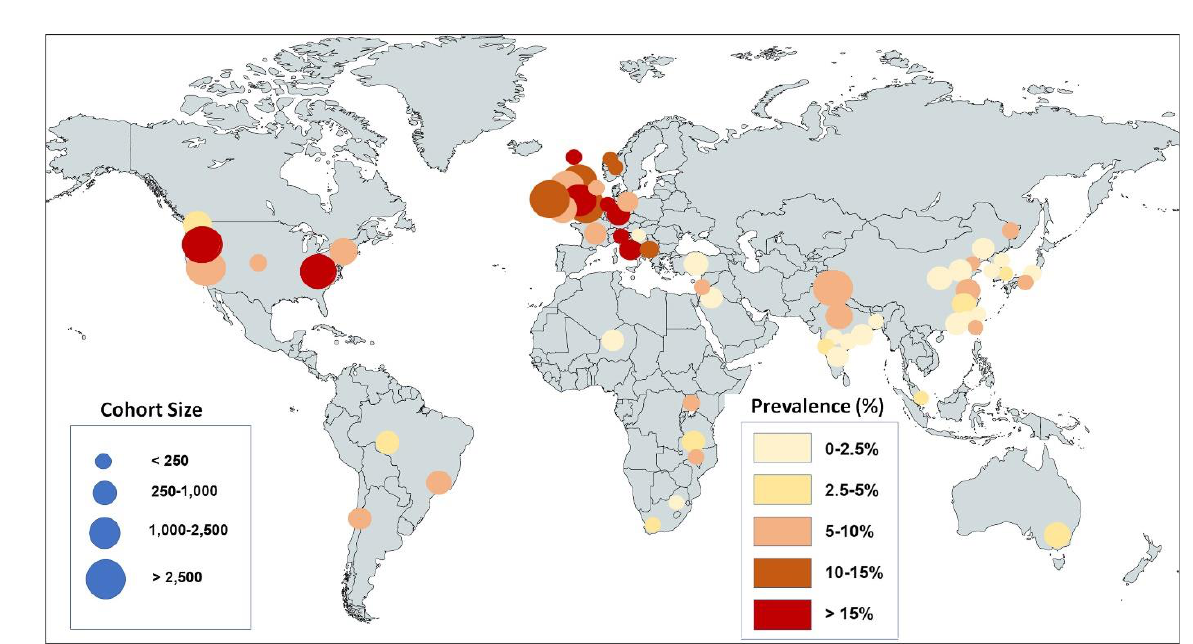
Figure 2. World map showing the locations of cohorts included in the systematic review and the prevalence of olfactory dysfunction caused by the omicron variant. The sizes of the circles represent the size of the cohort as indicated in blue; the color gradient indicates the prevalence range as shown on the right side. Note that populations of European ancestry have larger prevalence levels than populations of non-European ancestry. Table 2. Compilation of the 32 studies that compares prevalence of olfactory dysfunction due to omicron with that due to delta or other variants.